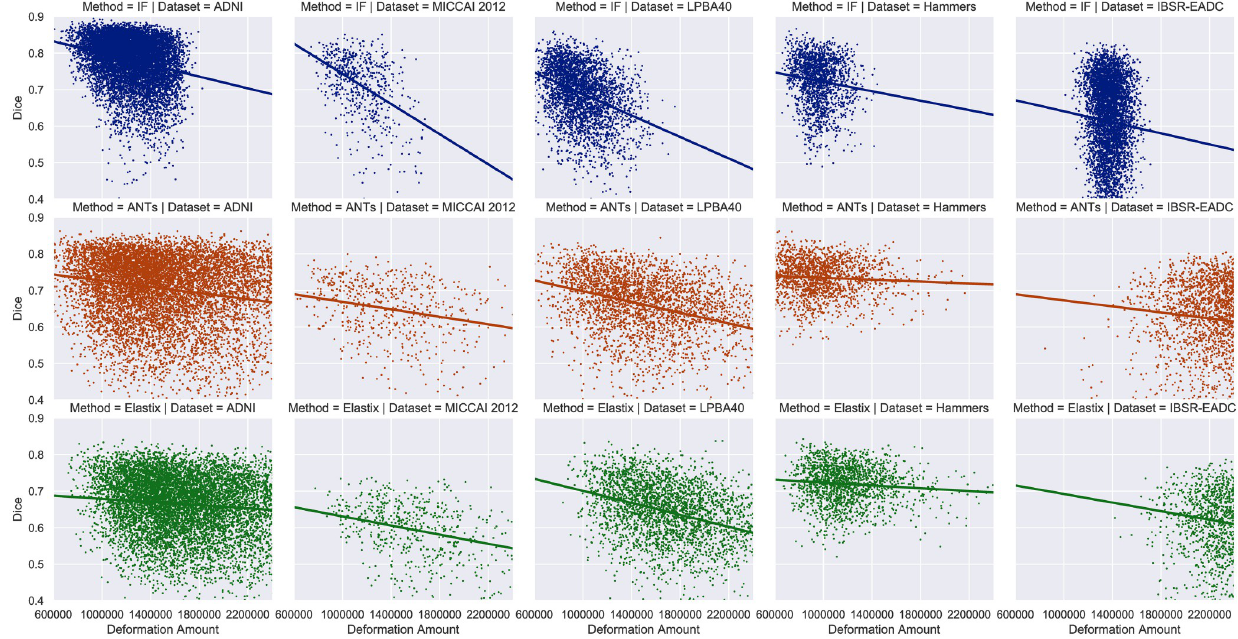
Fig 10. Approximately linear relationships between the expected Dice coefficient and the amount of deformation in registration. A subplot is made for each registration method and each dataset. The deformation amount is the sum of the Euclidean norms of all the displacement vectors. The best-fitting straight line through the data points is based on linear regression. For better illustration, some data points are out of range, thus absent in this figure. ANTs: ANTs SyN. IF: the integrated flow (our